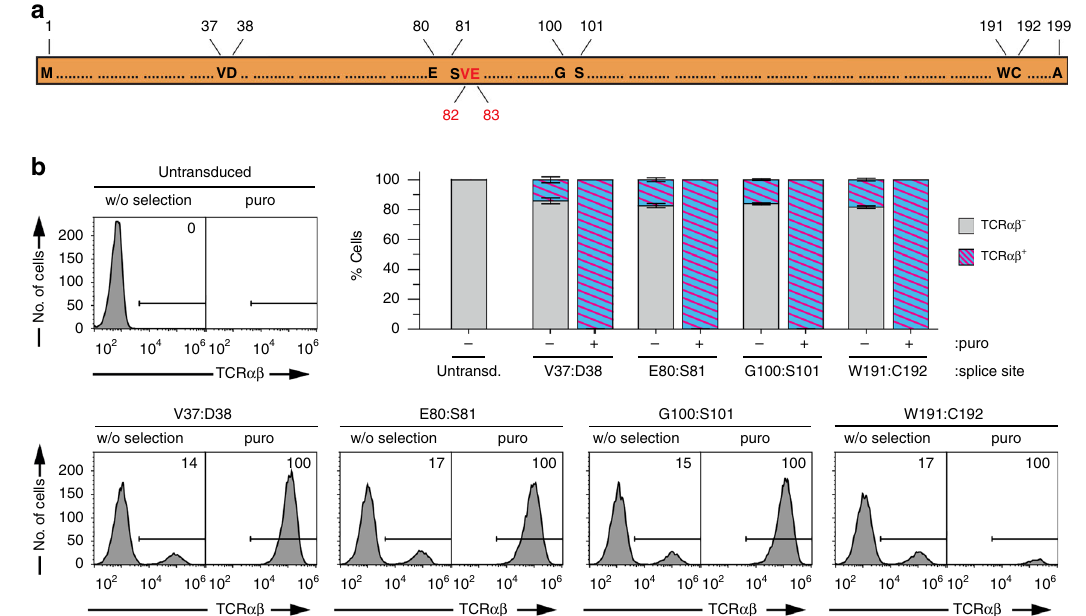
Fig. 10 Characterization of further splice sites for puromycin acetyltransferase in human T cells. a Schematic representation of puromycin acetyltransferase where splice sites, and fi rst and last amino acids are indicated. Remaining amino acids are shown as dots. Numbers represent the amino acid position. The fi rst identi fi ed splice site V82:E83 is highlighted in red. E80:S81, G100:S101 and N192:C192 are scarless constructs, while V37:D38, V82:E83 and W191: C192 contain a scar of six residues ( ‘ SGY ’ at positions − 3, − 2, − 1 and ‘ SSS ’ , at positions + 1, + 2, + 3). b Flow cytometric analysis of Jurkat T cells transduced with the indicated constructs. Upper left and lower panel, representative histograms of living cells gated using forward versus side scatter. Numbers indicate the percentage of murine TCR β + cells. Upper right panel, stacked bar chart showing the percentage of murine TCR β + cells under the indicated conditions. Values represent mean (± standard deviation) of three independent experiments. Standard bar graphs with individual data points are shown in Supplementary Fig. 25b. Source data are provided as a Source Data fi